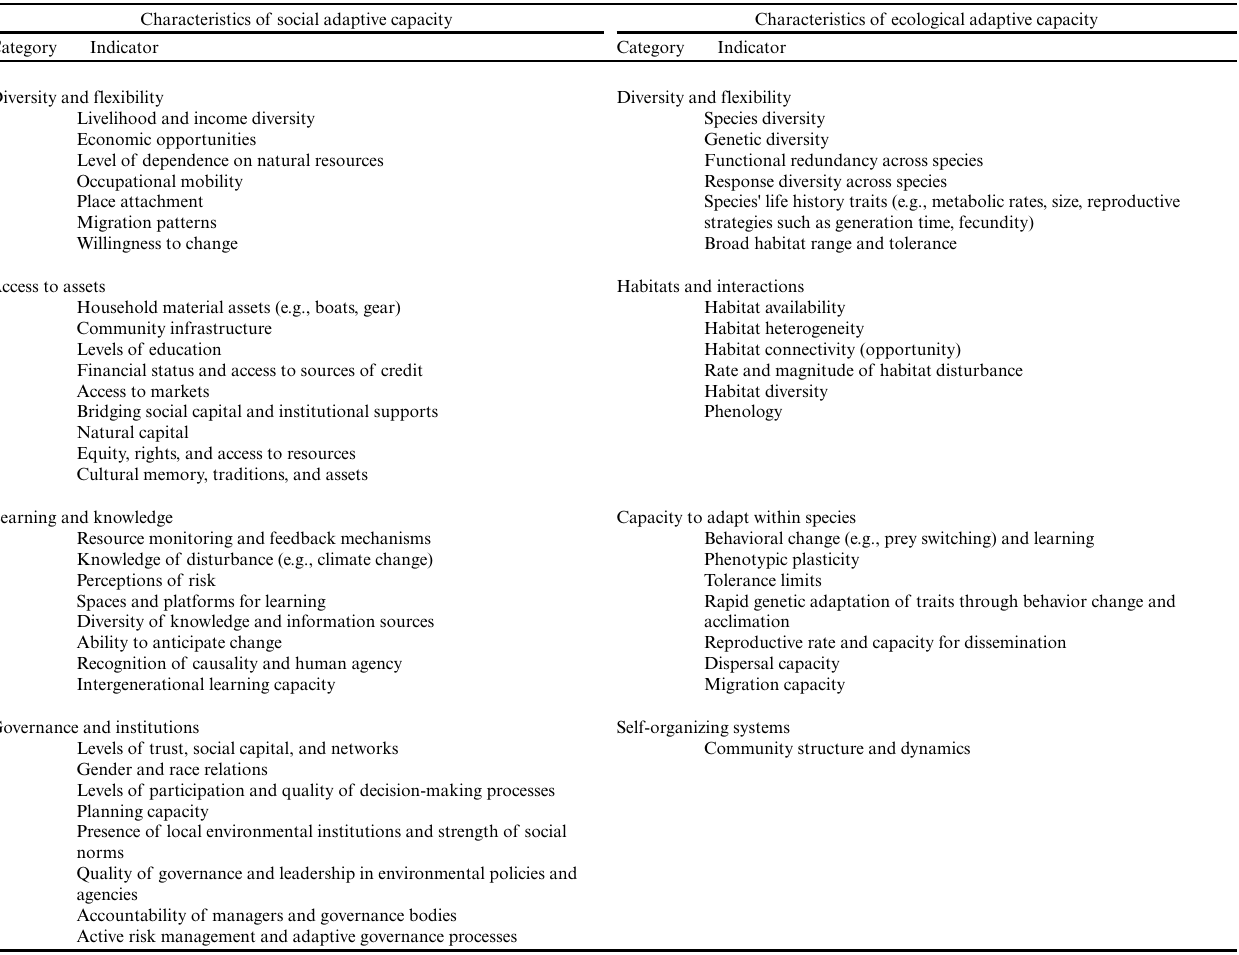
Table 2. Examples of generic social and ecological measures used in assessments of adaptive capacity. Many of these measures are operationalized as indicators in